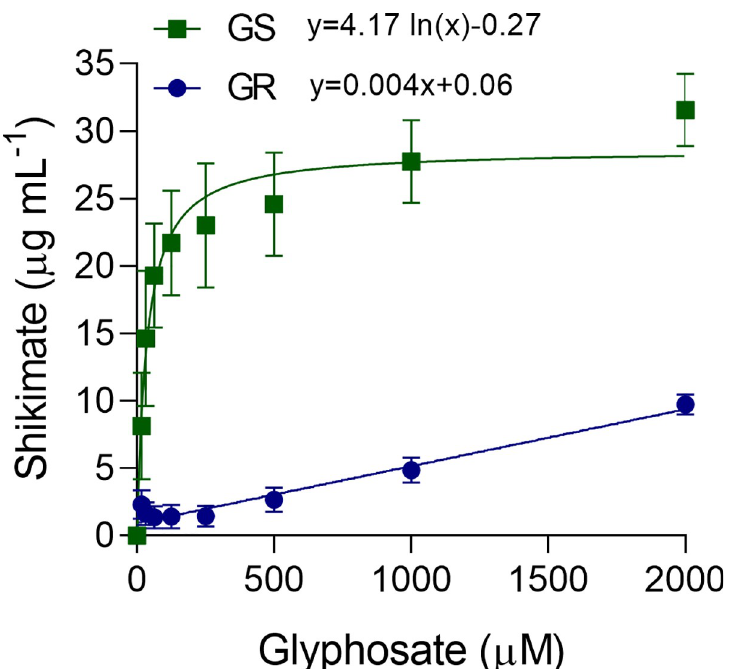
Fig 2. Shikimate accumulation in glyphosate-susceptible (GS) and -resistant (GR) wild poinsettia ( Euphorbia heterophylla ). Data points represent the means ± standard errors (n =